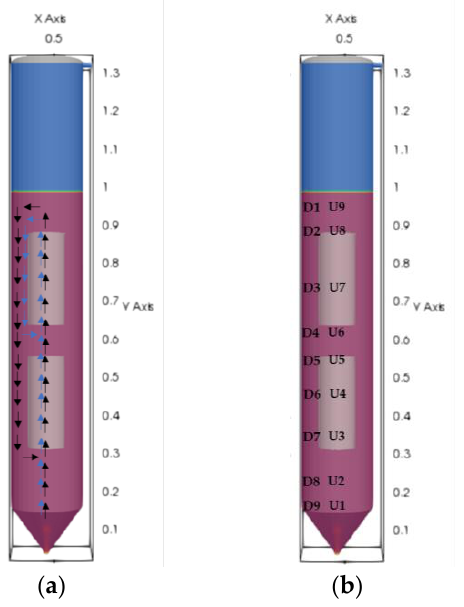
Figure 6. ( a ) Draft tube loop circulation; ( b ) Sampled points.